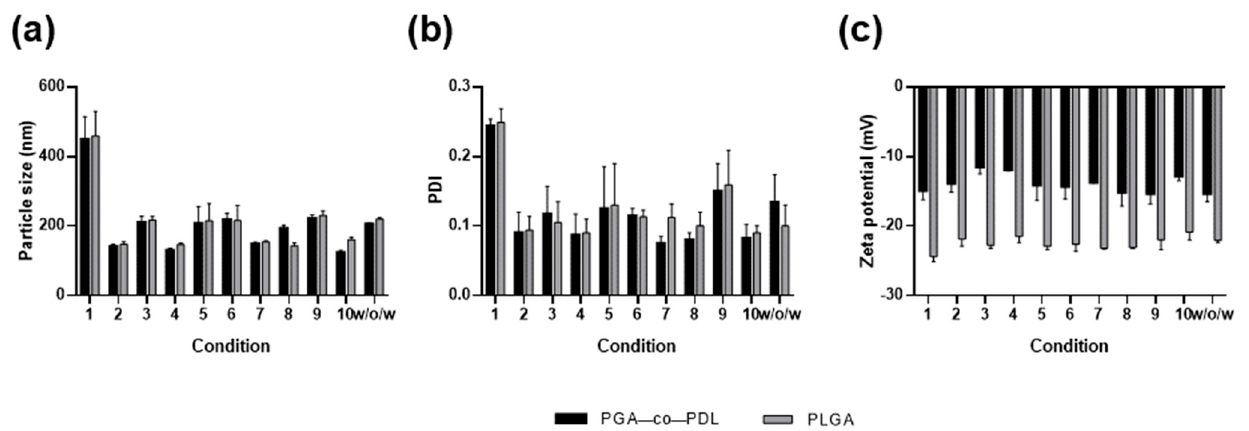
Figure 1. Analysis of particle size, poly dispersity index (PDI), and zeta potential of nanoparticles. ( a ) particle size, ( b ) PDI, and ( c ) zeta-potential. Conditions 1 to 10 are described in Table 1 to prepare NPs by o / w single emulsion solvent evaporation method, and w / o / w represents the values for NPs prepared by double-emulsion solvent evaporation method, using condition 10 for PGA-co-PDL and condition 8 for PLGA. Data represent mean ± SD, n = 3.